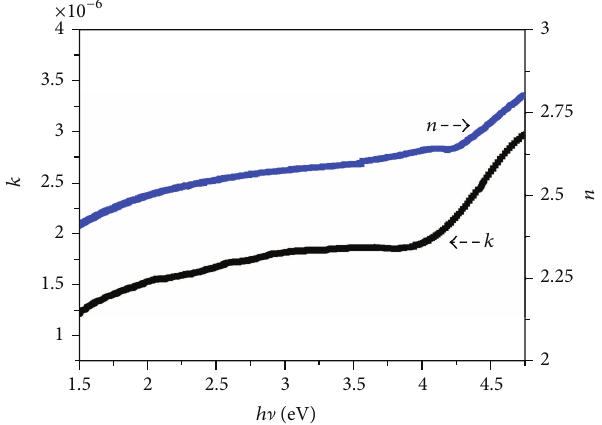
Figure 7: Variation of 𝑛 and 𝑘 with photon energy.